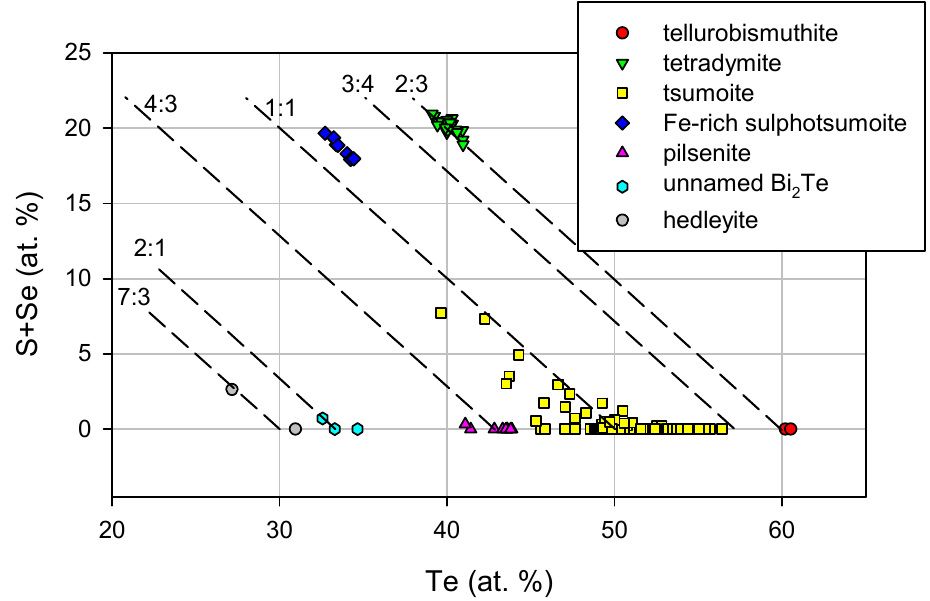
Figure 10. Chemical composition of Bi-(sulpho)tellurides in a Te versus S + Se (at. %) plot; numbers show Me:X ratio.